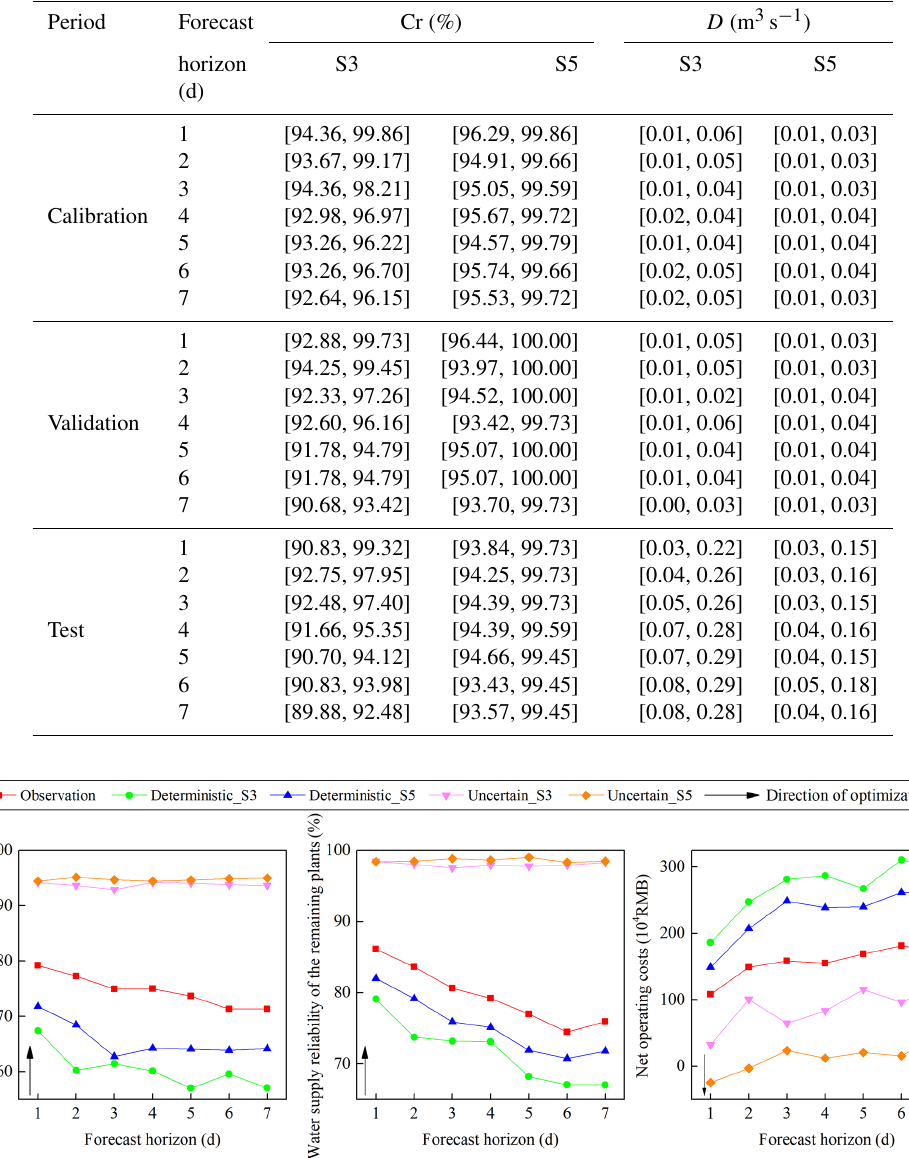
Table 5. Ranges of interval performance metrics ([min, max]) for all the 24 reservoirs under S3 and S5.